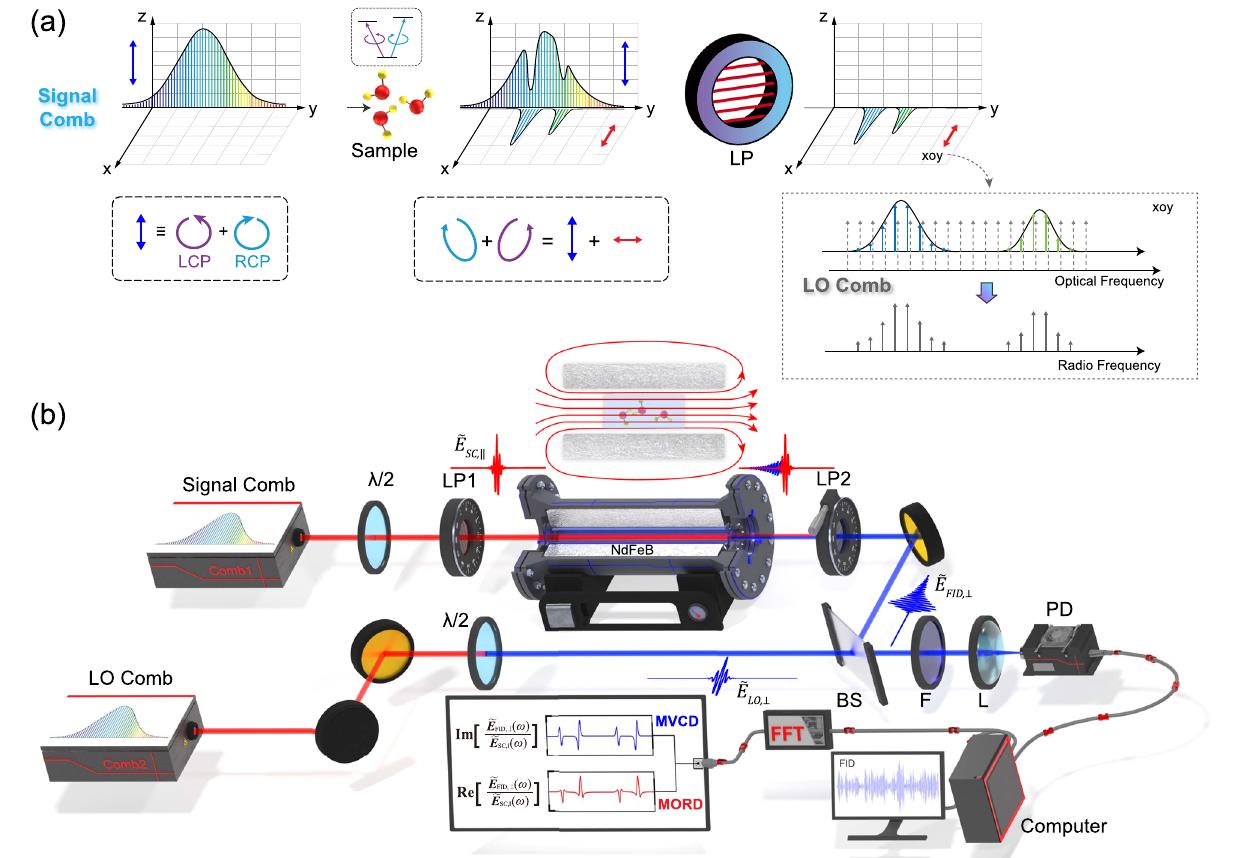
Fig. 1|BasicprinciplesandexperimentalsetupoftheDC-OAS system.a Sketch of the basic principles of the magnetic optical activity (MOA) response of the frequency comb in the cross-polarization scheme. The signal comb (SC) polarized along z axis, is incident on the sample cell in the magnetic fi eld. For the Zeeman- split absorption lines of paramagnetic molecules, the left- and right-circularly polarized components (LCP: 4 M J = (cid:2) 1; RCP: 4 M J = +1) of the linearly polarized fi eld have different wavelength-dependent complex propagation constants, which results in magnetic optical rotatory dispersion (MORD) and magnetic vibrational circular dichroism (MVCD). After interacting with the paramagnetic sample, the polarizeddirectionofthe spectral components involved in the resonant transition rotates, resulting in MOA signal polarized along x axis. The MOA signal in optical frequency is down-converted to radio frequency by multiheterodyne beating with thelocaloscillator(LO)comb.Thelinearpolarizer(LP)orientedalongxaxisisused